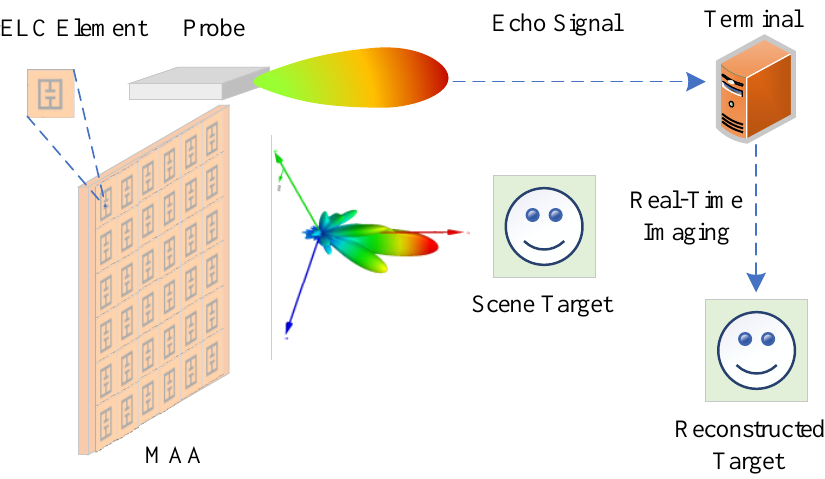
Figure 1. Schematic diagram of the frequency-diverse imaging